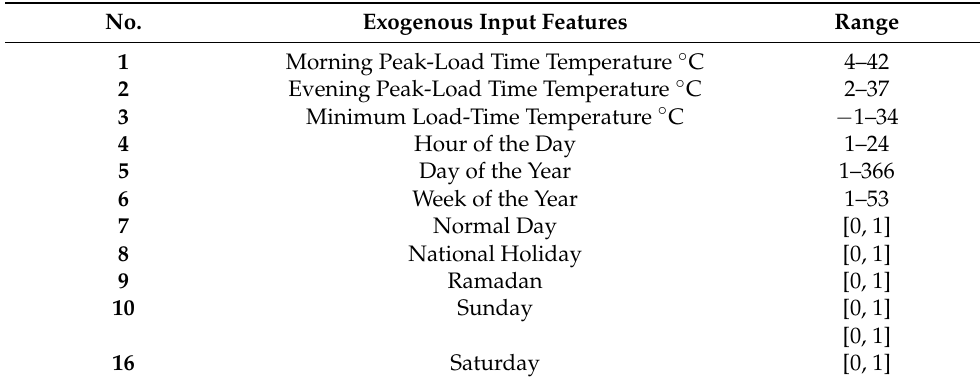
Table 5. Exogenous related to demand at the hour to be predicted.